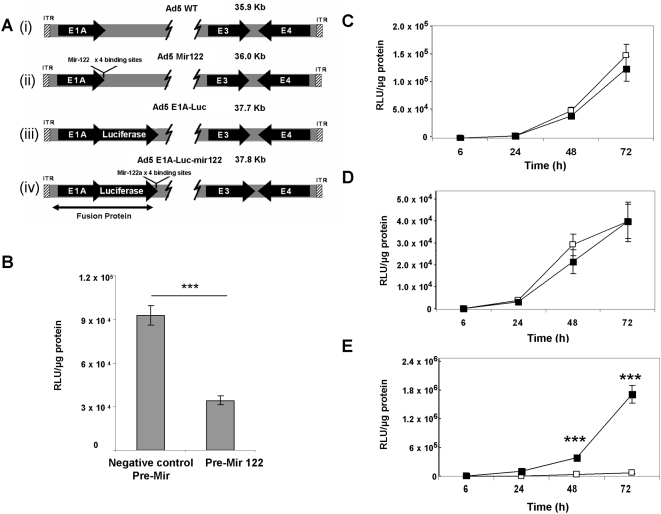
Regulation of E1A expression.(A) Structures of viruses engineered and used in this study. (i) Ad5-WT (ii) Four tandem repeats of binding sites for mir-122 were inserted into the 3′ UTR of E1A. (iii) Luciferase coding sequence was inserted into Ad5 to generate a fusion with the E1A coding sequence. (iv) Four tandem repeats of binding sites for mir-122 were inserted into 3′ UTR of luciferase in the virus shown in iii. (B) A549 cells were seeded at 5×104 cells per well and transfected with pre-mir122 (Ambion) or pre-mir negative control (Ambion). Immediately following transfection Ad-E1A-Luc-mir122 was added at 10 vp/cell in 450 µl DMEM media (10% FCS). 18 h later, 30 pmol/well of pre-cursor mir122 and negative control precursor microRNAs were added to each well in addition to the 500 µl described above. Luciferase readings were performed at 24 h (p = <0.0005). (C–E) Time course of luciferase expression of Ad5-E1A-Luc (solid squares) and Ad5-E1A-Luc-mir (open squares) in mir-122-negative OVCAR3 (C) and A549 (D) cells, and in mir-122-positive Huh7 cells (E) in vitro. (*** P<0.0005).